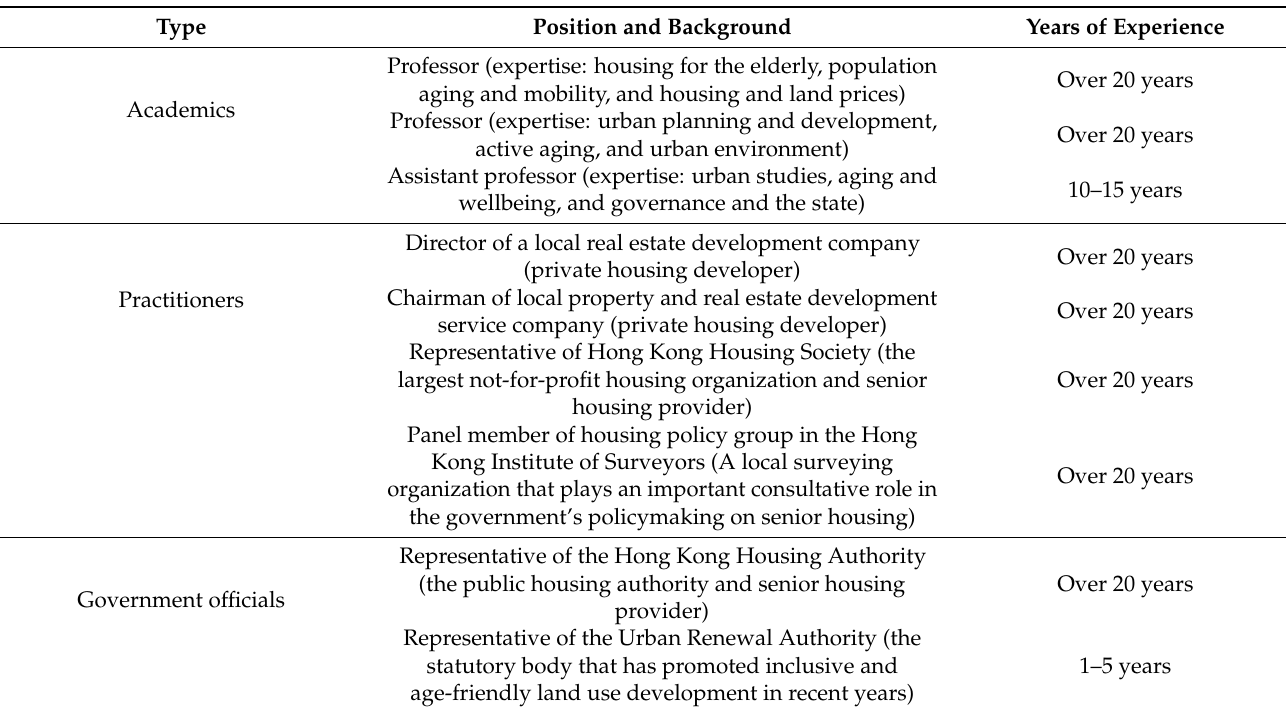
Table 2. The profile of the local